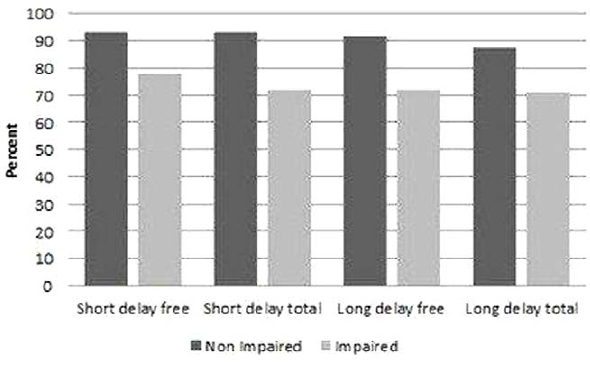
Figure 1. Suitability indices of construct validity. doi:10.1371/journal.pone.0050056.g001 Figure 2. Suitability indices of external